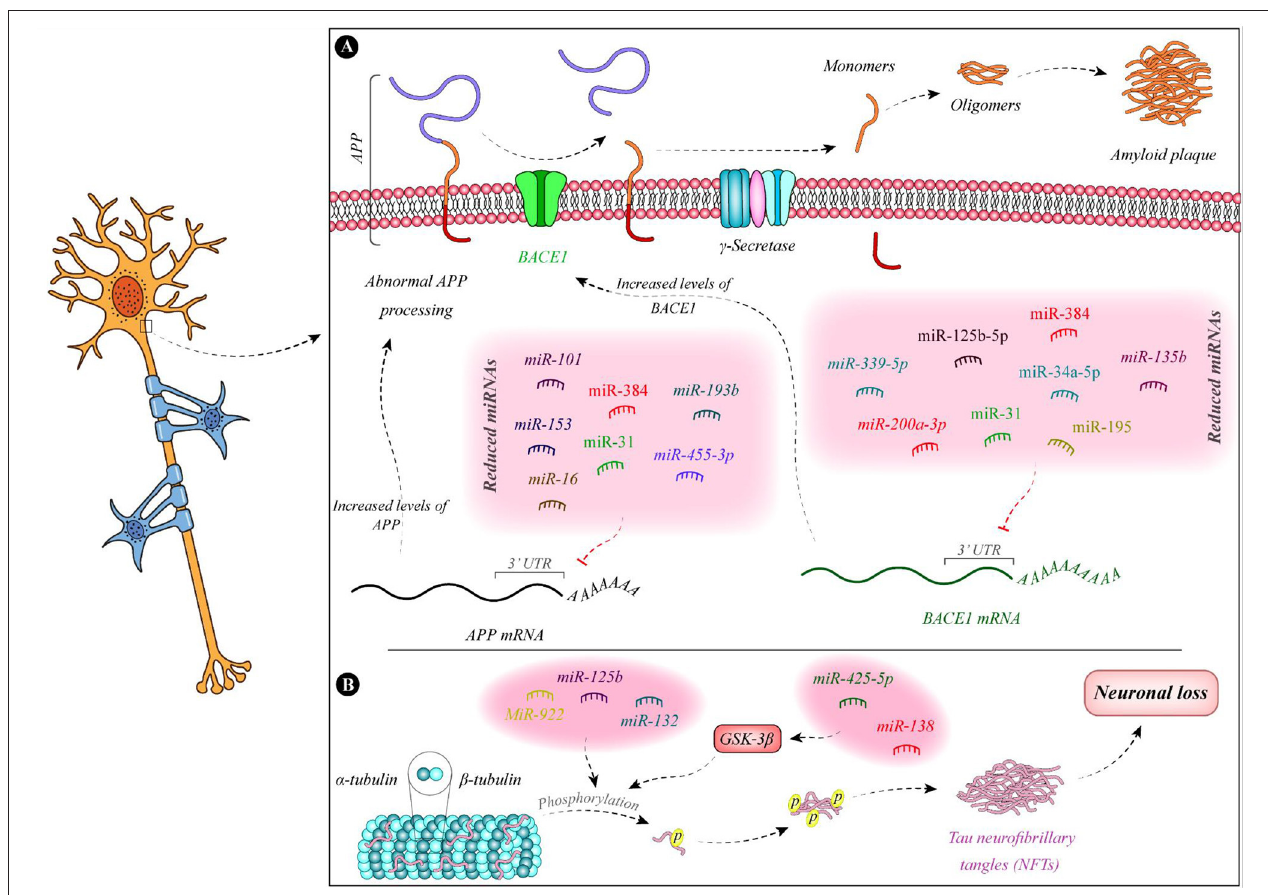
FIGURE 1 | Summary of the function of miRNAs in the pathogenesis of AD. (A) Expressions of miR-135b (Zhang et al., 2016b), miR-195 (Zhu et al., 2012), miR-34a-5p ( Liang et al., 2020), miR-384 (Liu et al., 2014b), miR-125b-5p (Liang et al., 2020), miR-31 (Barros-Viegas et al., 2020), miR-200a-3p (Pan et al., 2019), and miR-339-5p ( Long et al., 2014) are decreased in patients with Alzheimer’s disease. These miRNAs bind with the 3’ UTR of BACE1 and decrease its expression. Therefore, the downregulation of these miRNAs leads to the upregulation of BACE1. In addition, expression levels of some APP-binding miRNAs namely miR-101 ( Vilardo et al., 2010), miR-153 (Liang et al., 2012), miR-16 (Liu et al., 2012), miR-384 (Liu et al., 2014b), miR-31 (Barros-Viegas et al., 2020), miR-193b (Liu et al., 2014a), and miR-455-3p (Kumar et al., 2019) is decreased in patients with Alzheimer’s disease. (B) Tau phosphorylation leads to defects in microtubules and induction of neurofibrillary tangles which result in neuron death. miR-138 and miR-425-5p are increased in Alzheimer’s disease. These miRNAs regulate the expression of GSK-3 β and enhance Tau phosphorylation (Wang et al., 2015b; Yuan et al., 2020). In addition, downregulation of miR-132 and upregulation of miR-125b and miR-922 leads to Tau hyperphosphorylation (Zhao et al., 2014; Salta et al., 2016; Ma et al.,